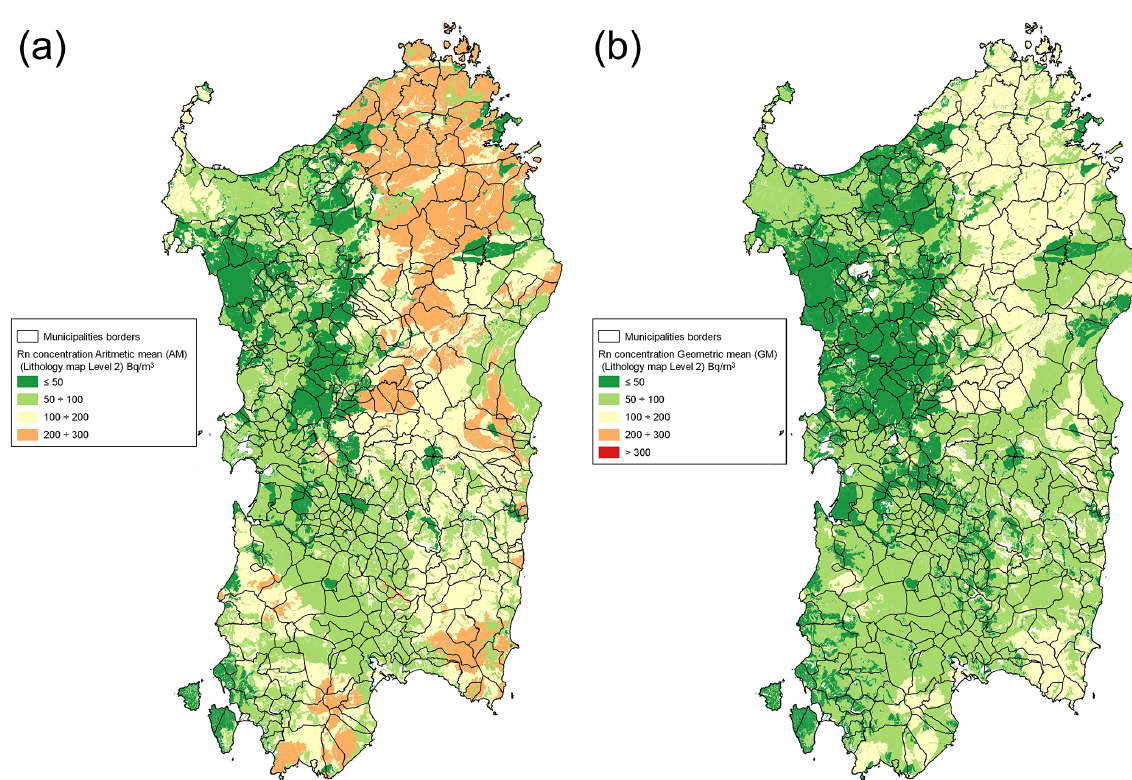
Figure 1. Arithmetic mean (a) and geometric mean (b) indoor radon concentration values in the Lithological Units based on the regional sample in